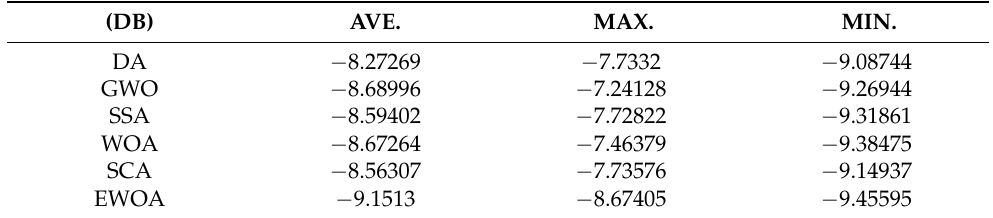
Table 7. Statistical results of the objective values obtained by different approach in the case with 10 populations and 120